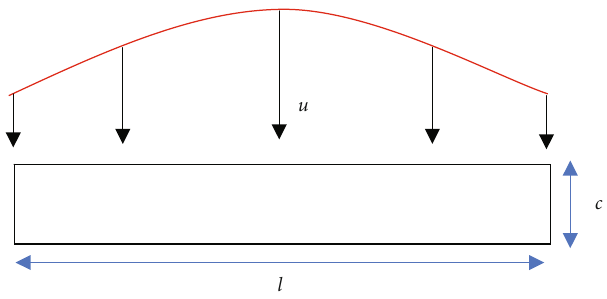
Figure 4: Illustration of the propeller slip- fl ow over a single